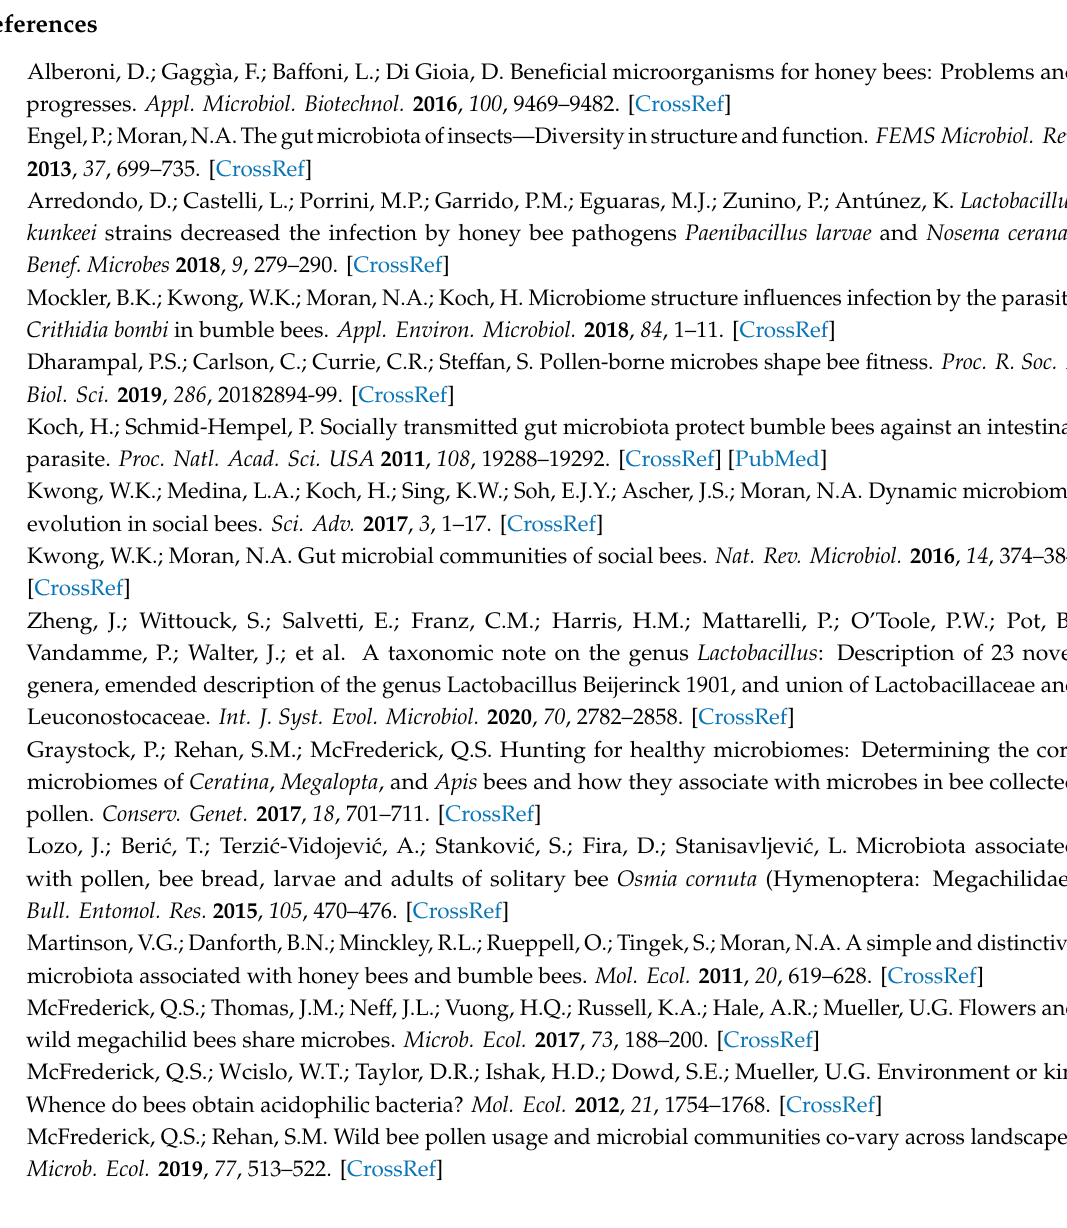
Table S1: Rbcl reads for each sample binned by genus, Table S2: 16S reads with the number of Sodalis reads reduced by 6.140%, Table S3: 16S reads with all Sodalis reads